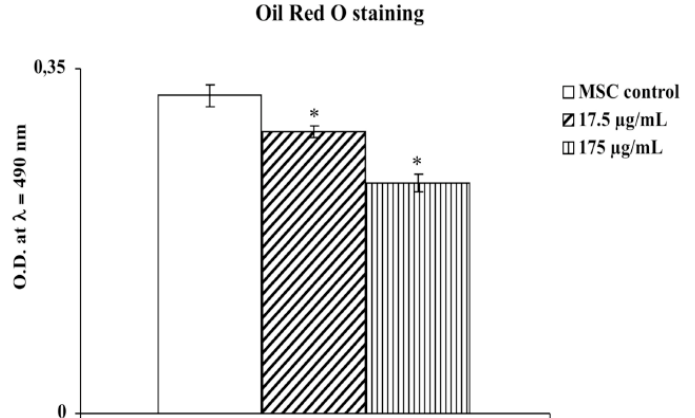
Figure 3. Effect of aqueous extract of leaves of M. foetida Schumach. et Thonn. on adipogenesis of hMSCs as measured by Oil Red O staining. Each value represents the mean ± S.D. of five experimental determinations. * p < 0.001 vs.